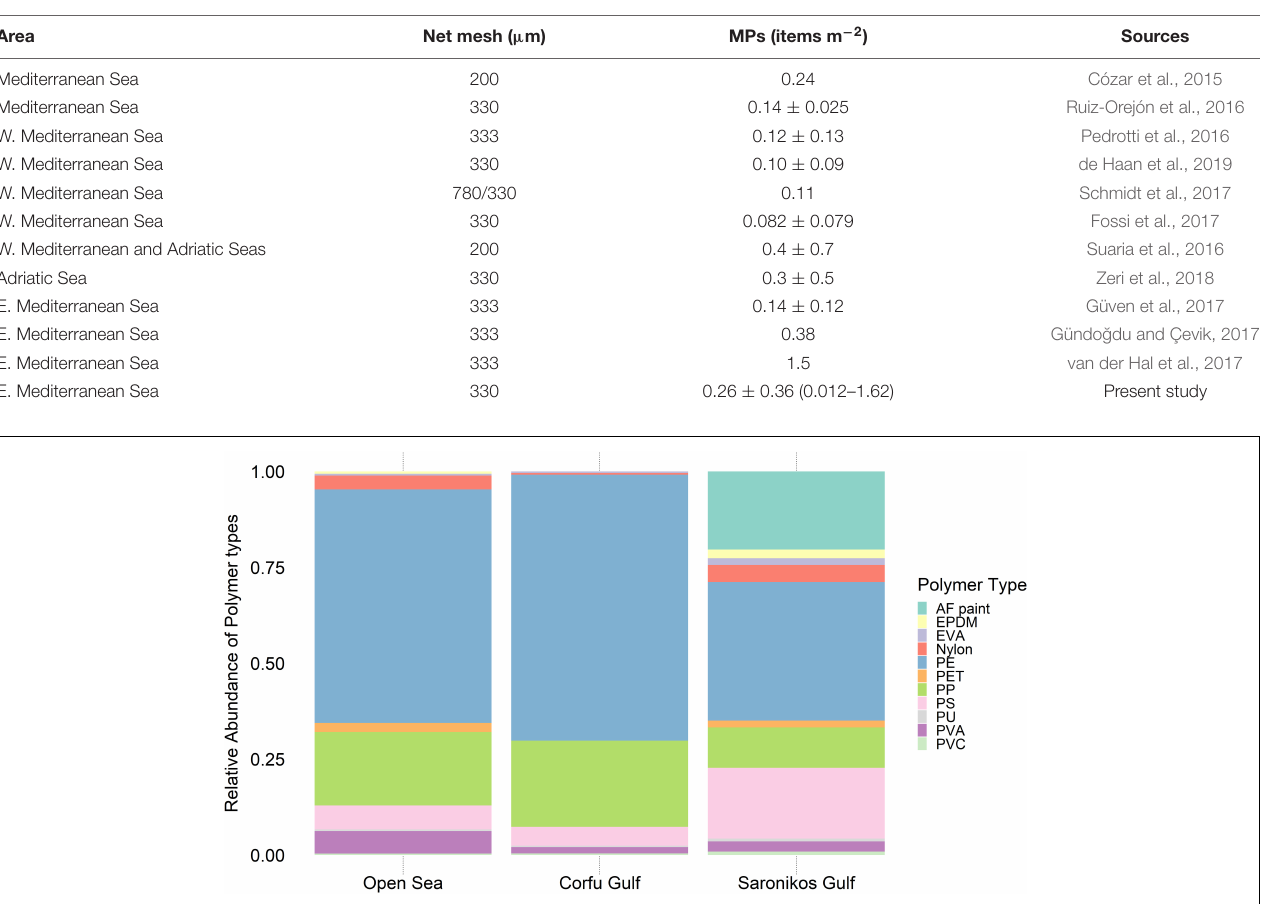
FIGURE 6 | Relative abundance of polymer types of MPs collected in the Ionian, Aegean and Levantine Sea (Open Sea), Corfu Gulf and inner Saronikos